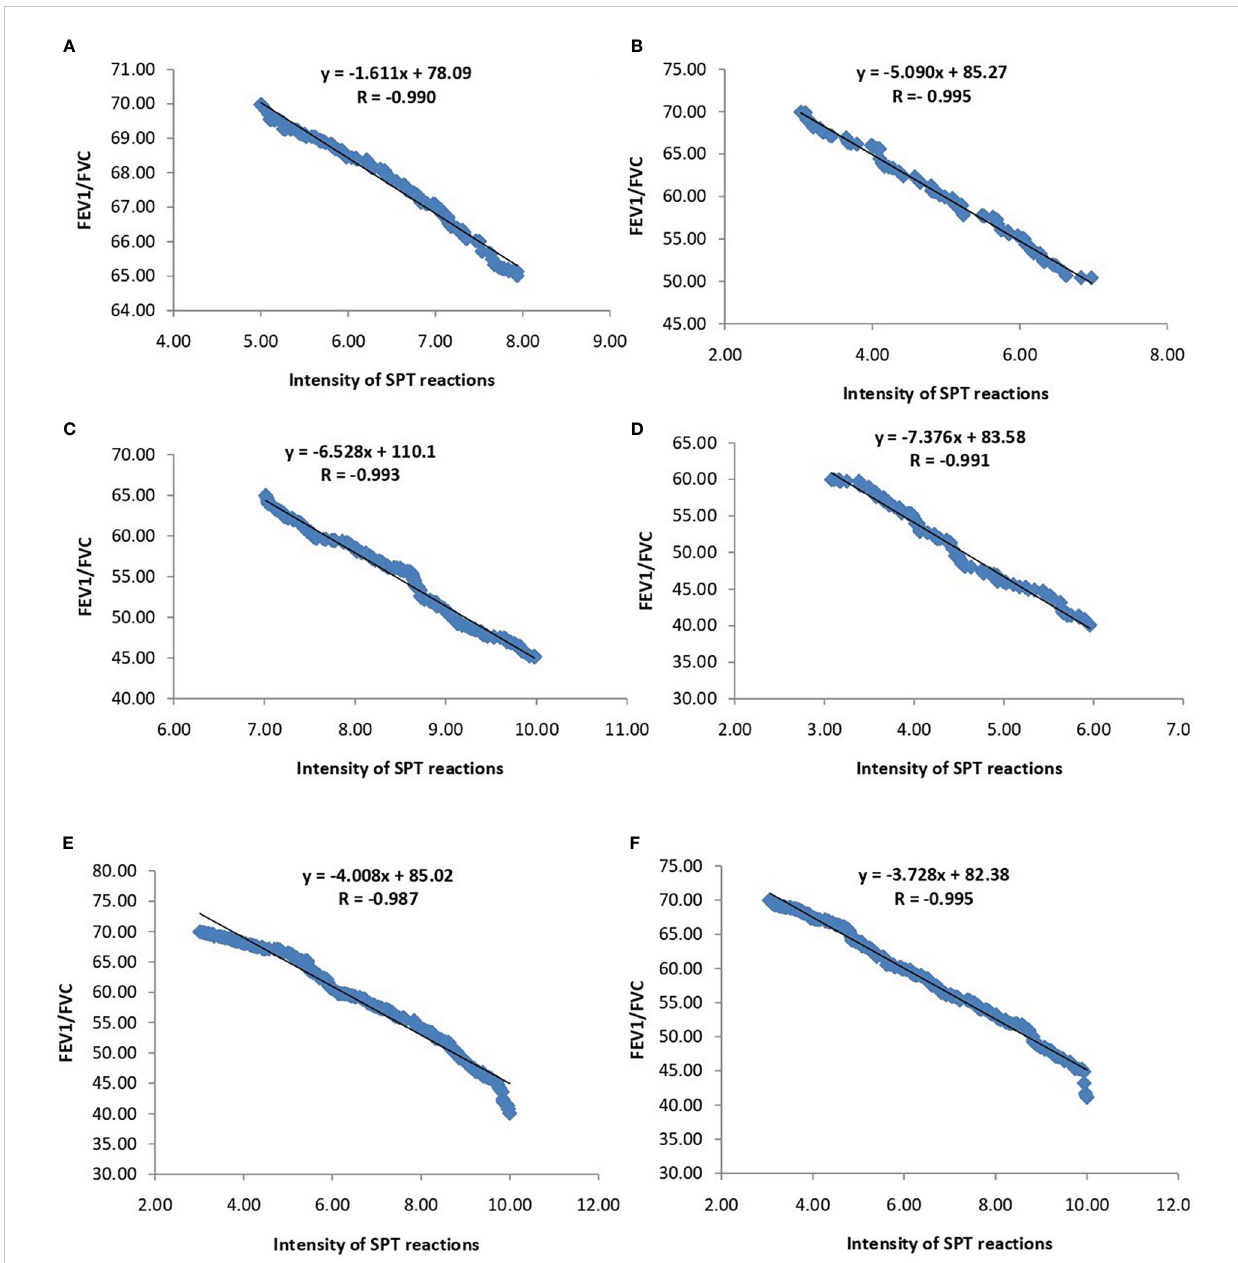
FIGURE 3 Regression analysis of FEV1/FVC ratio and intensity of SPT reactions (in terms of wheel diameter). (A) Children (B) Adolescents (C) Young adults (D) Old adults (E) Male (F)